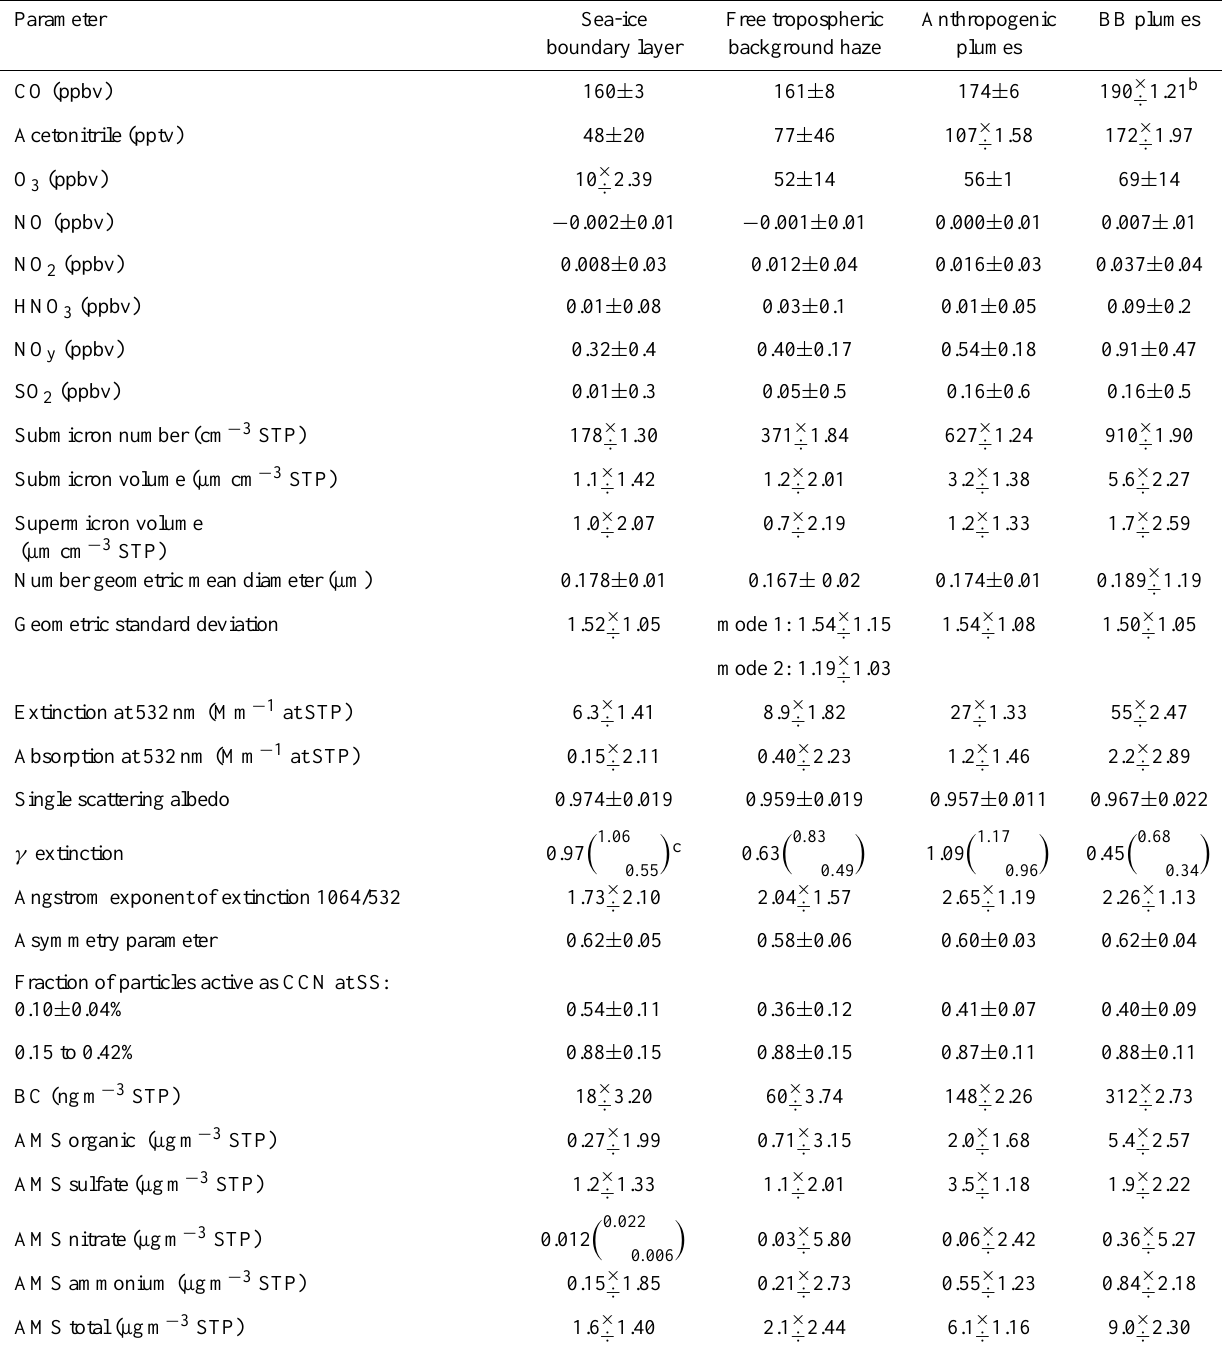
Table 3. Values of trace gas and aerosol parameters in different airmass types a